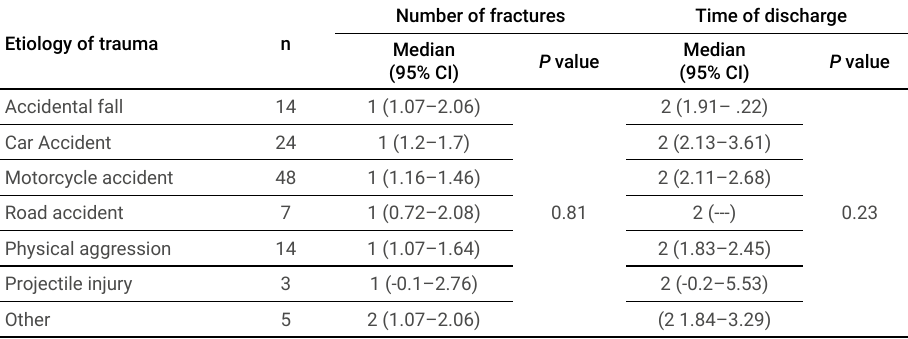
Table 5. Difference of medians of the number of fractures and time of hospital discharge according to the etiology of trauma in maxillofacial trauma patients. Etiology of trauma